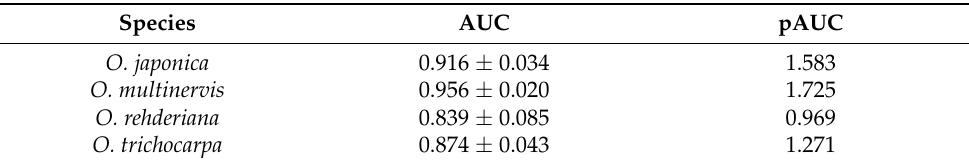
Table 2. Area under the receiver operating characteristic curves (AUC, mean ± SD) and partial AUC (pAUC) of Maxent models in predicting the distribution of four Ostrya species under present climate scenario.